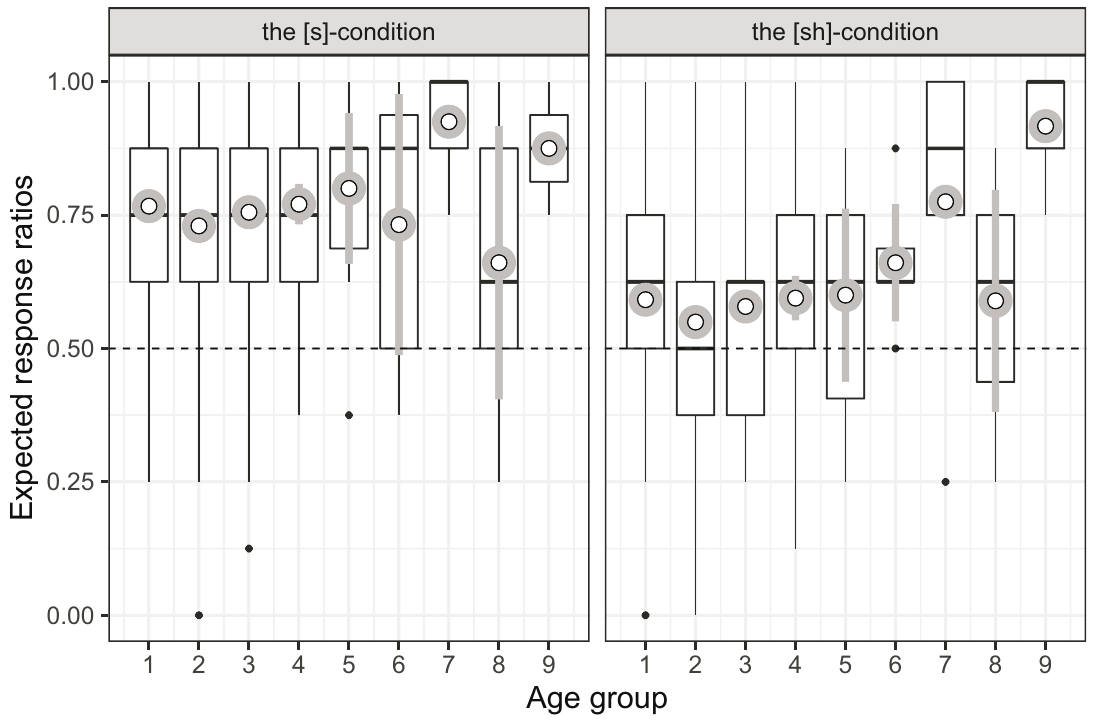
Figure 6: The e ff ects of age - groups on expected response ratios in the large data set. See Table 4 for which the age - group label corresponds to which age